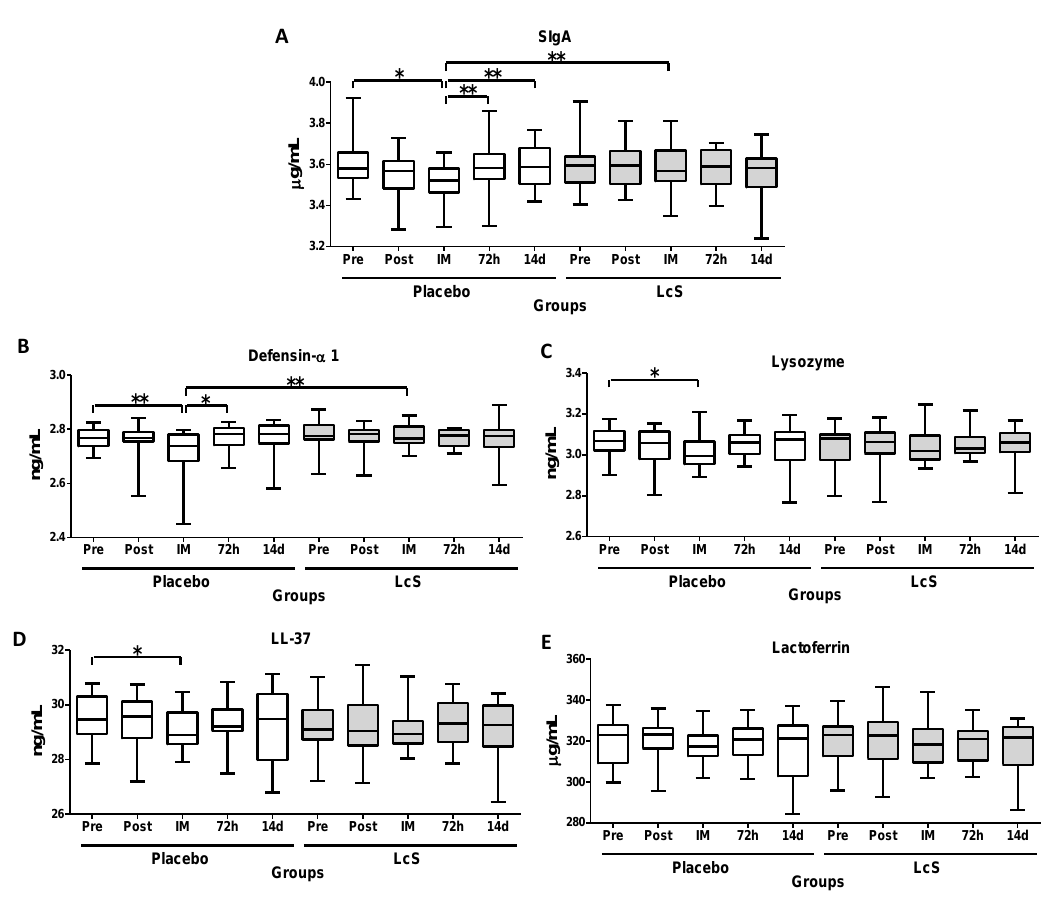
Figure 3. LcS maintain salivary immune protection after the marathon. Salivary concentration of secretory immunoglobulin A (SIgA, g/mL, ( A ) and the antimicrobial peptides defensing- 1 (ng/mL ( B ), lysozyme (ng/mL ( C ), cathelicidin LL-37 (ng/mL ( D ), and lactoferrin (g/mL ( E ) in the volunteers of the placebo and LcS groups at five different occasions: before (Pre) and 30 days after the ingestion of the fermented milk containing or not containing LcS (Post-ingestion); immediately (IM); 72 hours (72h) and 14 days (14 d) after the marathon ends. Values are presented in the median with the respective quartiles. The risk value was set at 5% ( p < 0.05). * p < 0.05 and ** p < 0.01.